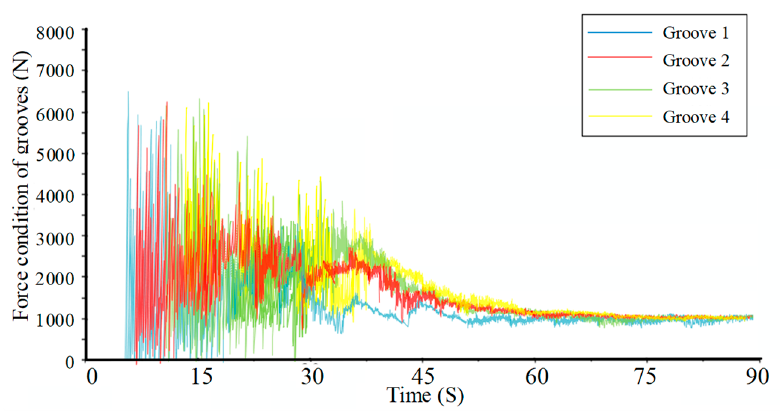
Figure 11. Impact forces acting on the four grooves.